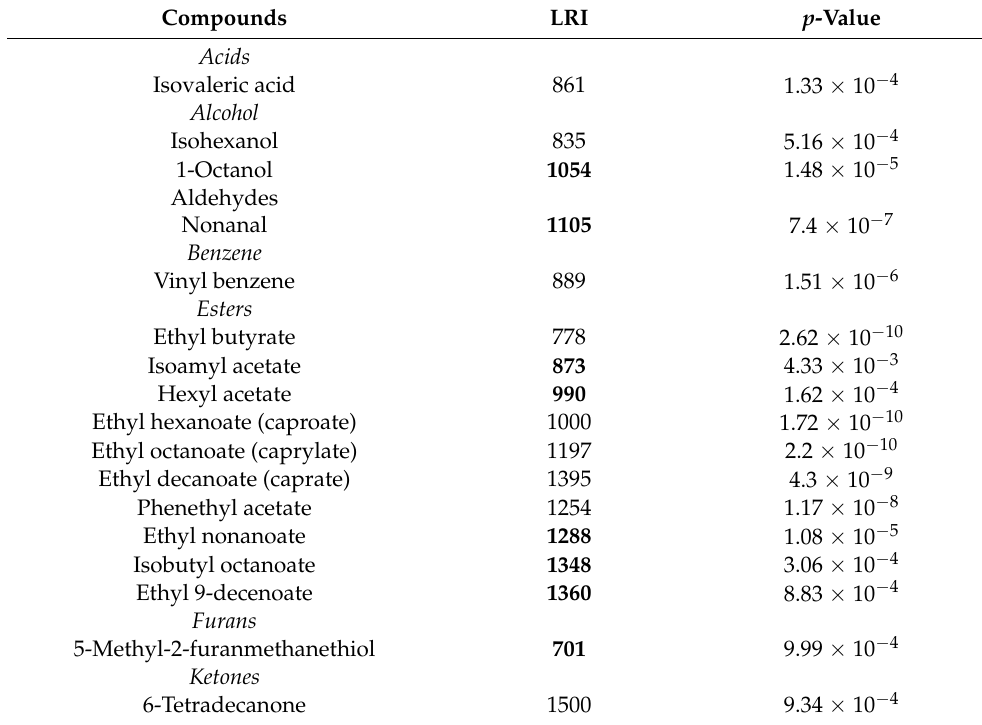
Table 3. Semi-volatile compounds that were present in beers brewed from barley and sorghum and were found to be highly significantly different in the median amount relative to the internal standard. LRI values that are bold were not